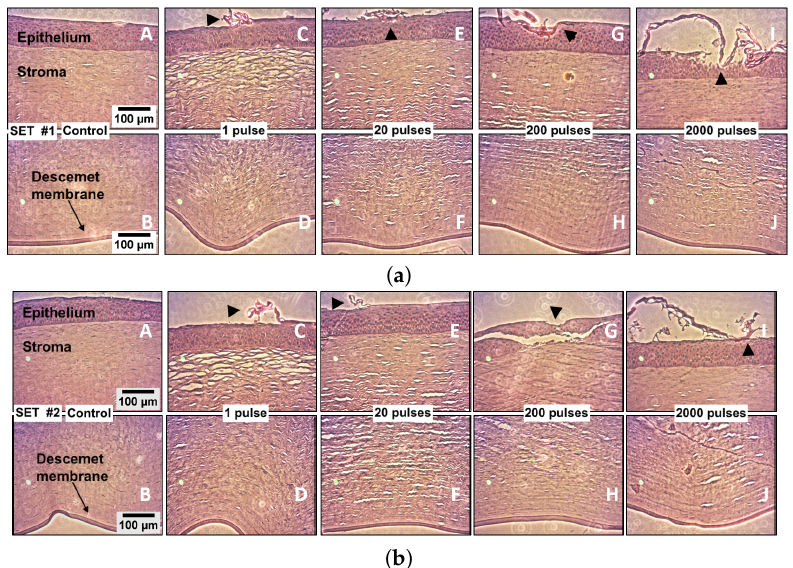
Figure 10. Histological analysis of both the controls and the laser irradiated corneas (Ep = 13 mJ). The pump laser pulses were delivered within aqueous humor into the AC to induce the cavitation bubbles; the cavitation sites are located about 1 millimeter below the Descemet’s membrane within the AC. The first column in each set ( A , B ) shows the corneal epithelium, stroma, and Descement’s membrane in the controls, i.e., the non-irradiated corneas. In both sets, ( C , E , G , I ) show the epithelium and the upper part of the stroma, while ( D , F , H , J ) show the bottom part of the stroma and the Descemet’s membrane, under irradiation conditions at varying numbers of pulses. The induced pressure in the pig eye was 15 mmHg. Notice the intentionally laser ablated landmarks made on the epithelium surface, which are indicated by arrowheads in ( C , E , G , I ) on both